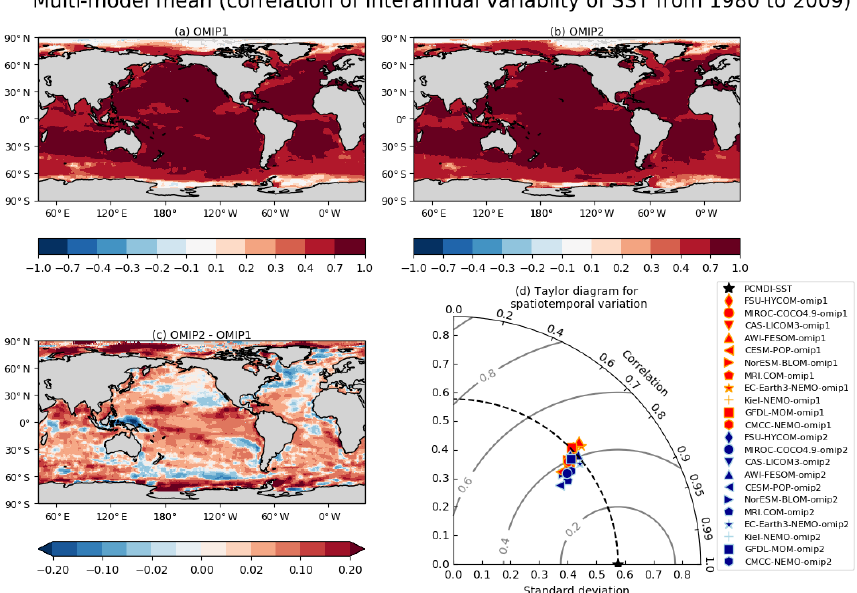
Figure E2. Multi-model mean correlation coefficients of monthly SST anomaly relative to the monthly climatology for the period 1980–2009 between simulation and PCMDI-SST. (a) OMIP-1, (b) OMIP-2, (c) OMIP-2 − OMIP-1. (d) Taylor diagram of the total space–time pattern variability of monthly SST anomaly relative to the monthly climatology for OMIP-1 and OMIP-2 simulations relative to PCMDI-SST, with standard deviations expressed in units of ◦ C. See Figs. S52–S54 for results of individual